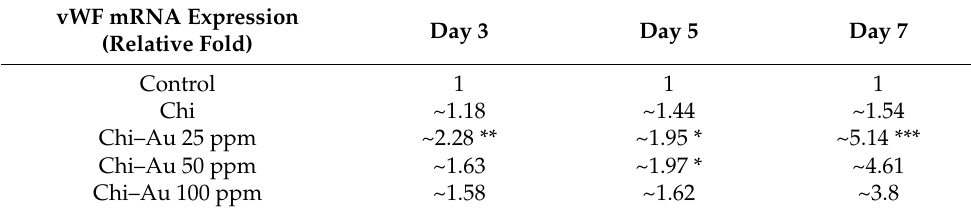
Table 5. vWF mRNA expression at 3, 5, and 7